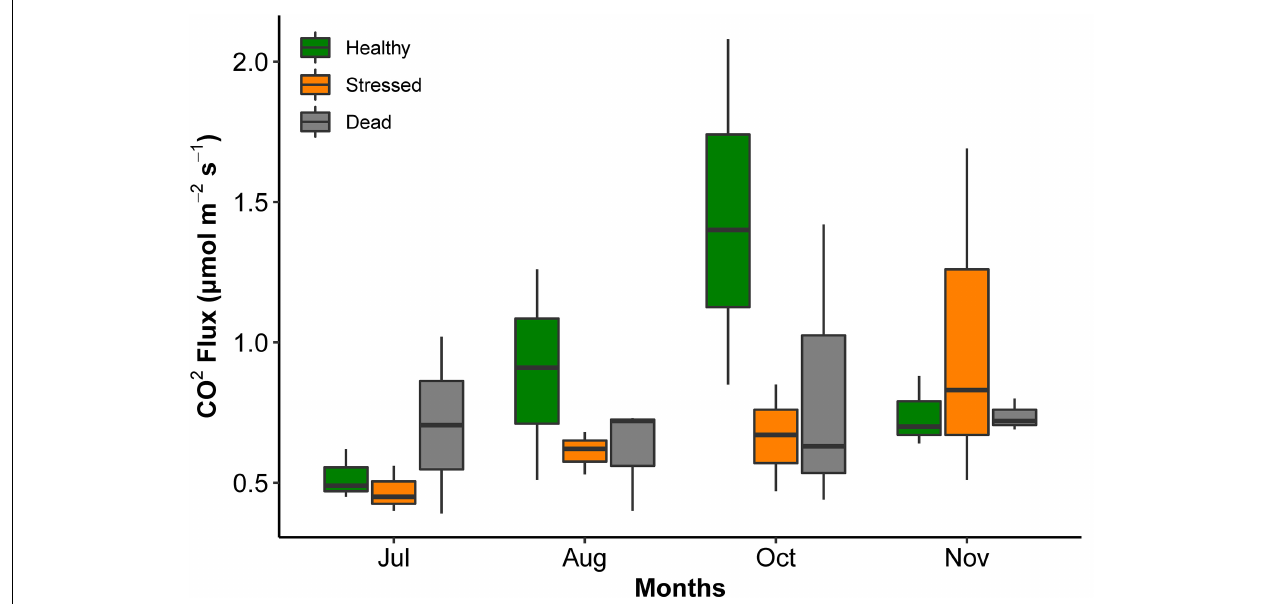
FIGURE 5 | CO 2 efflux from sediment at the three mangrove zones at St Kilda, South Australia, measured over several months in 2021. All measurements were taken at low tide. There were no significant differences between the zones and